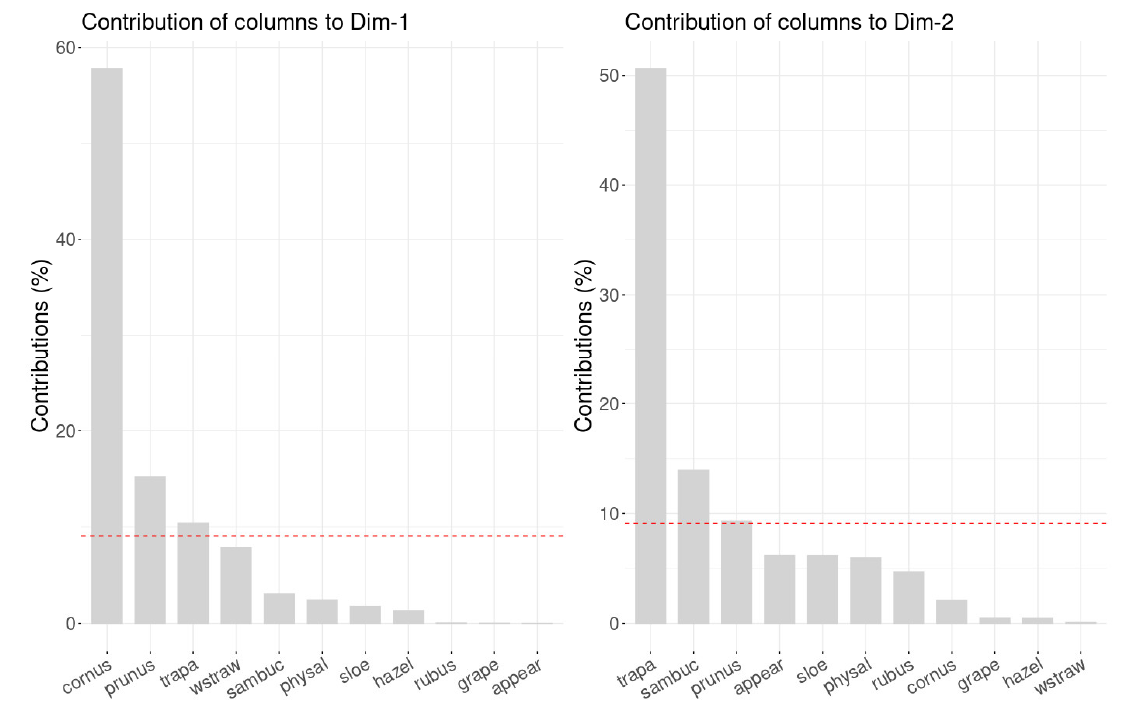
Figure 10. Percentage contributions of wild taxa to dimensions 1 and 2 in Figure 9.